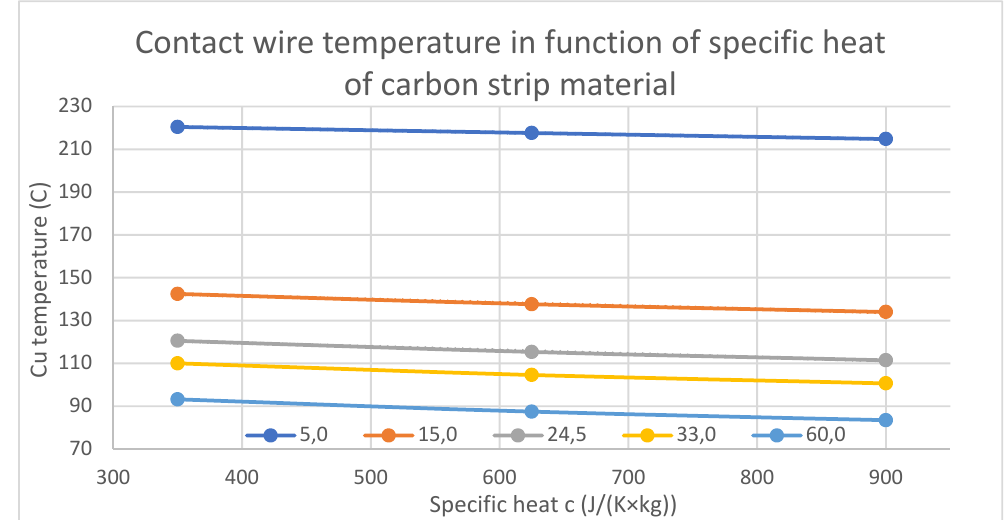
Figure 15. Contact wire temperature as a function of thermal conductivity of the carbon strip material for specific heat.